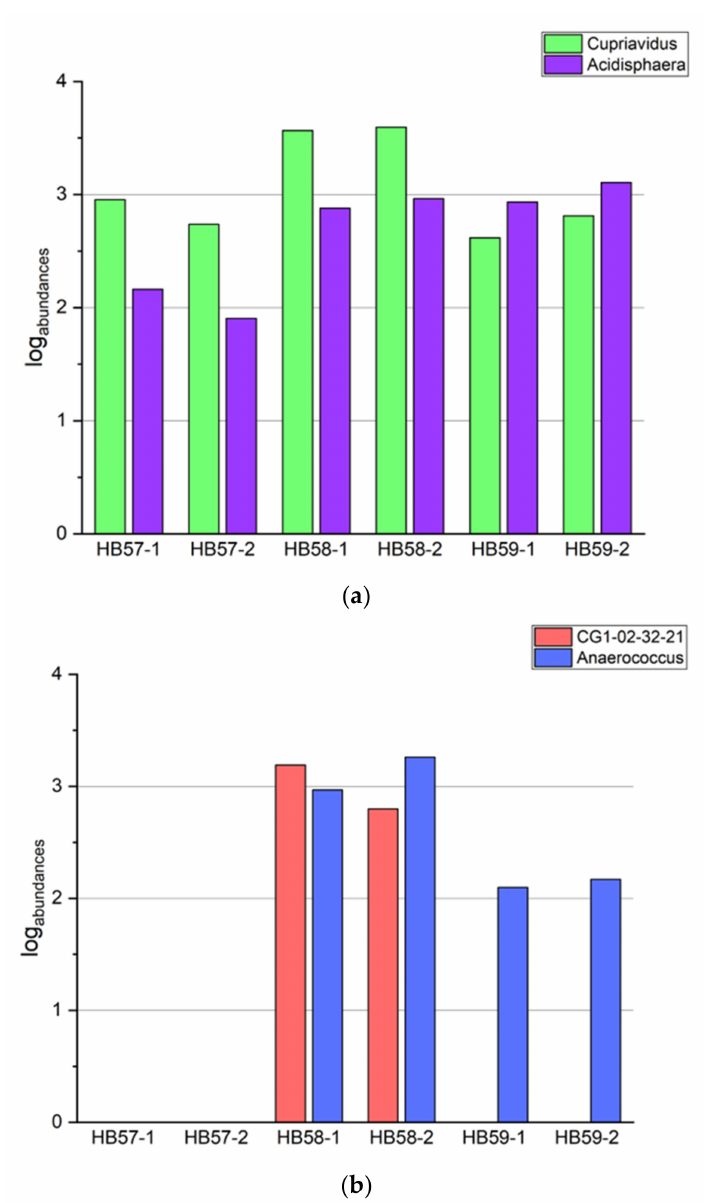
Figure 5. Logarithmic abundances (r-values, see Equation (2) in Section 2.4) of special OTUs dis- tinguishing the bacterial communities of the three different sampling sites: ( a ) Cupriavidus and Acidisphaera ; ( b ) Micrarchaeales CG1-02-32-21 and Anaerococcus